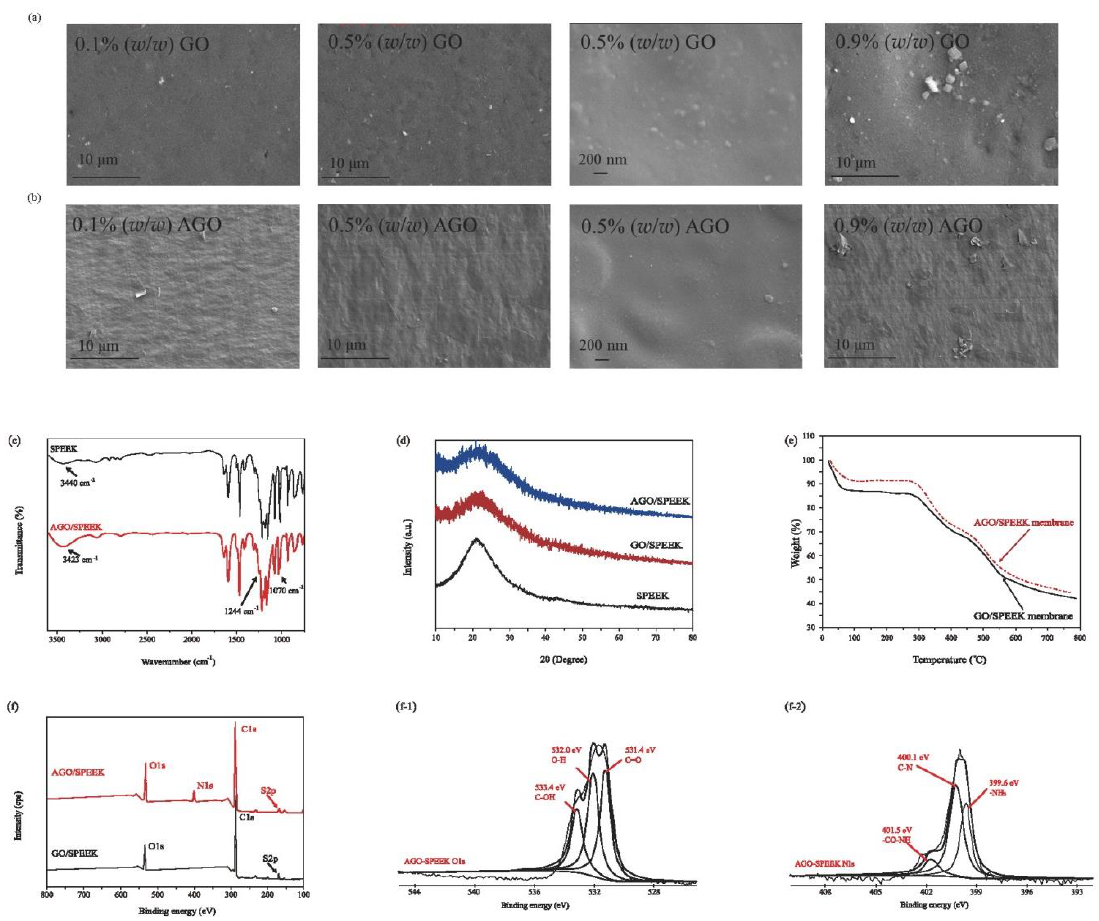
Figure 2. Characterization of films. ( a ) SEM of GO/SPEEK films, ( b ) SEM of AGO/SPEEK films, ( c ) FTIR spectra, ( d ) XRD pattern, ( e ) TGA curves, ( f ) XPS survey spectra, ( f-1 ) O1s spectra and ( f-2 ) N1s spectra of 0.5% ( w/w ) AGO/SPEEK films.